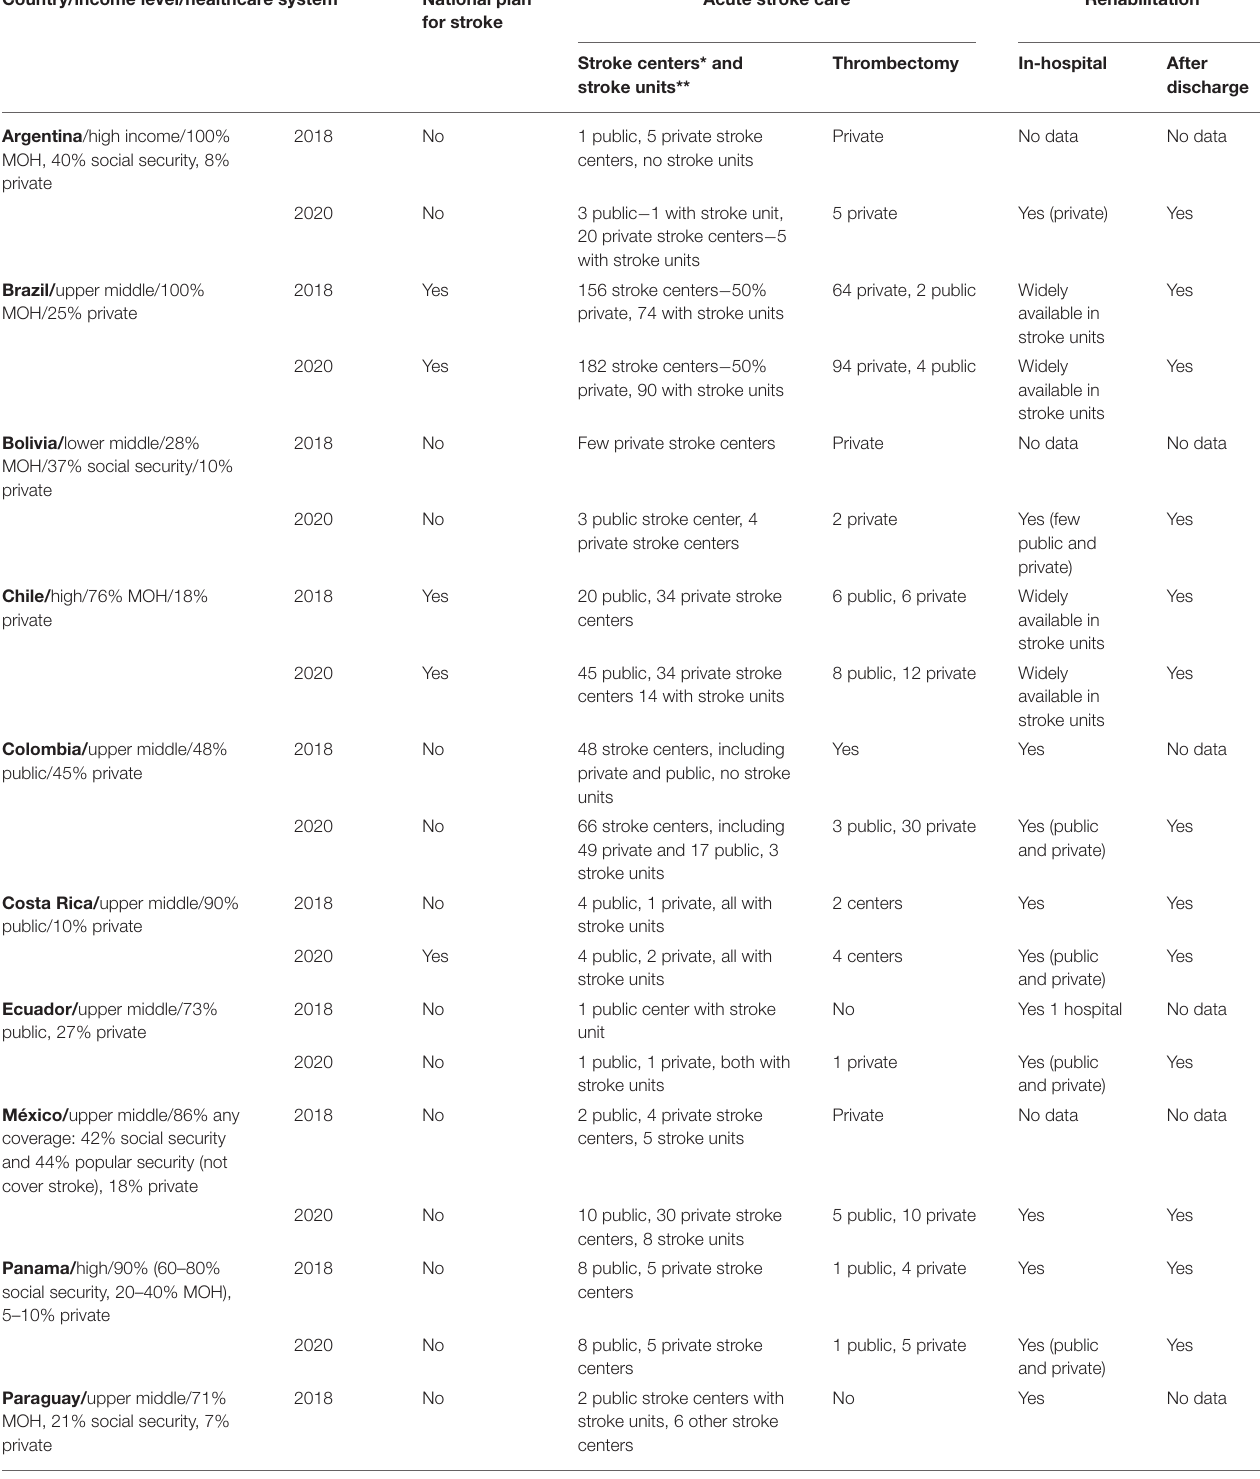
TABLE 2 | Stroke care in Latin American countries,